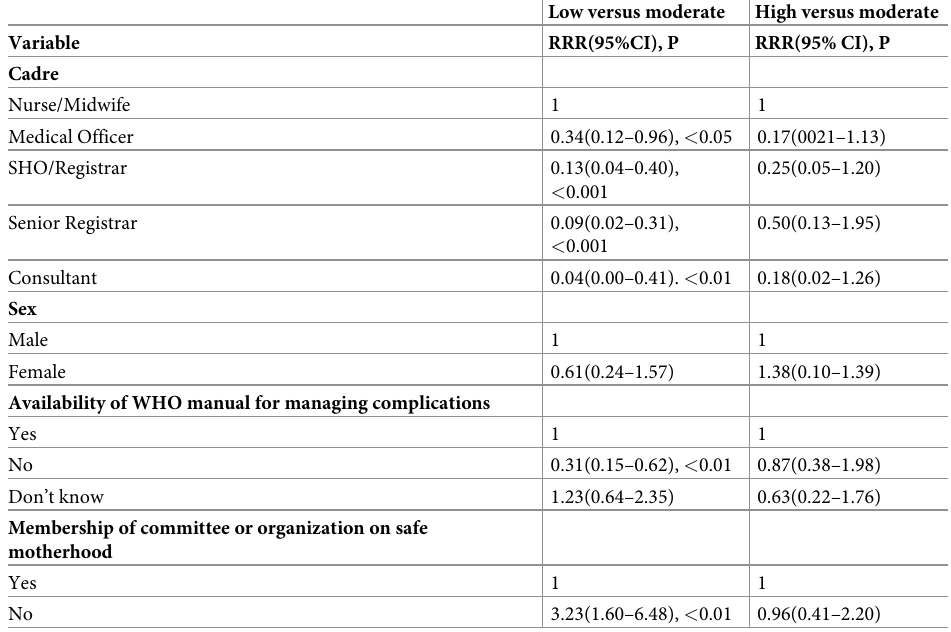
Table 5. Multinomial logistic regression predicting the factors associated with knowledge of emergency obstetrics